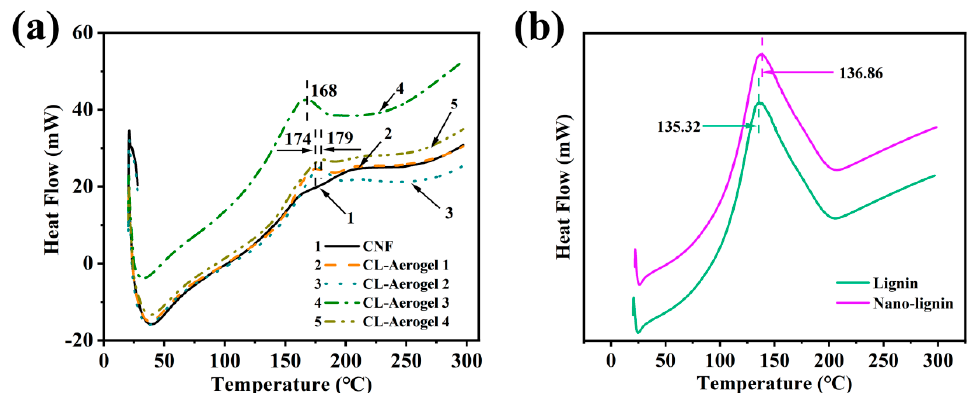
Figure 4. DSC curves of prepared aerogels of different lignin content ( a ),initial and nano-lignin ( b ) (0, 4.5 wt%, 9 wt%, 13.5 wt%, 18 wt%).